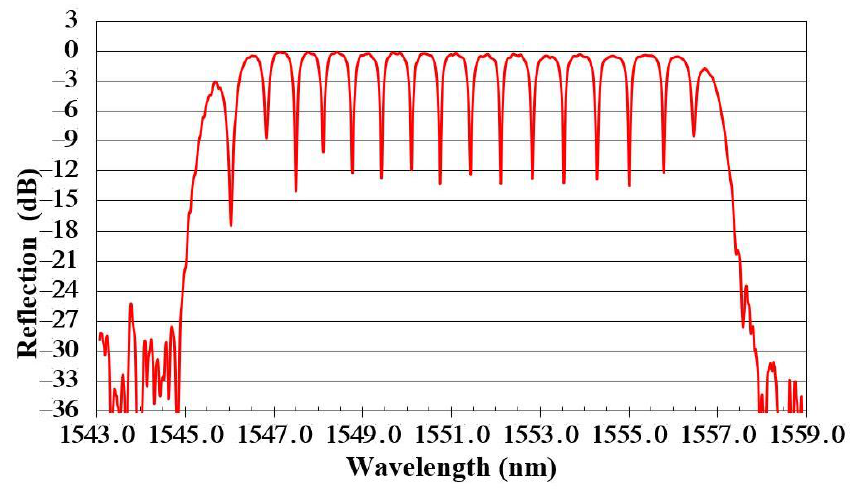
Figure 12. Measured reflection spectrum for a 2D chirped fiber